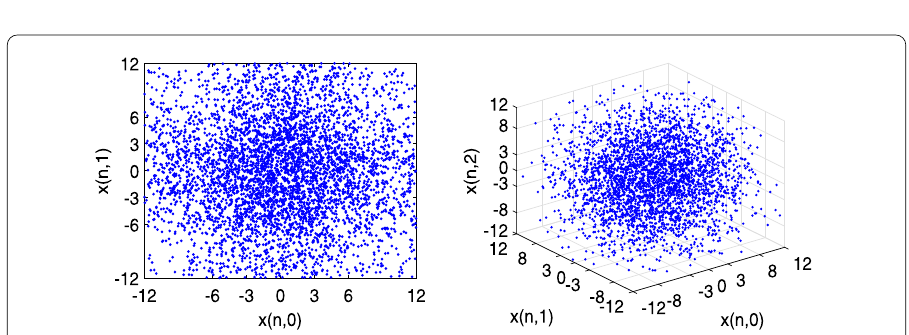
Figure 3 Simulations for system (5) with (29), where n = 0,1, ... ,10,000. In the 2-D graph, k = 1, and the initial values are x (0,0) = 1, x (0,1) = –0.1. In the 3-D graph, k = 2, and the initial values are x (0,0) = 0.1, x (0,1) = –0.1, and x (0,2) =